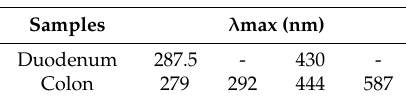
Table 5. UV-Vis absorption maxima for the overlaid spectra subtractions of duodenum and colon samples of piglets fed with a control or 5% GP